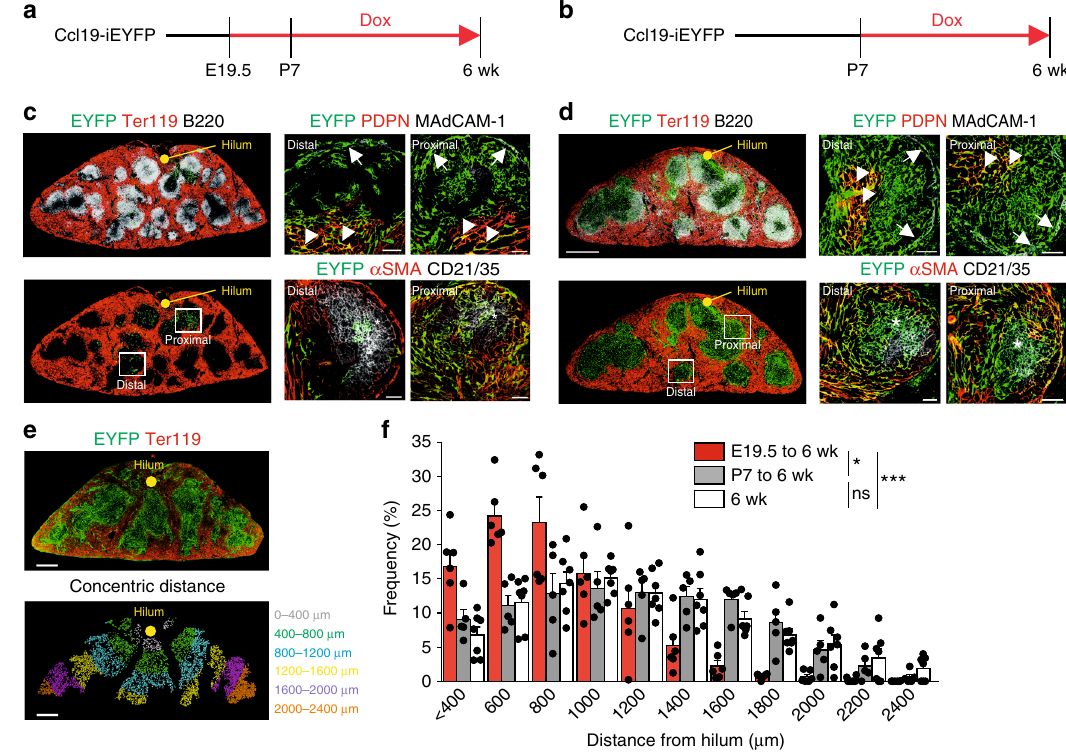
Fig. 4 Staggered commitment of splenic white pulp organizer cells along the developing arterial tree. a , b Ccl19-iEYFP mice were treated with doxycycline from E19.5 ( a , c ) or P7 ( b , d ). Distribution and phenotype of EYFP + cells in the white pulp of 6-week-old mice were determined by confocal microscopy using the indicated antibodies. Boxes show region of higher magni fi cation in right images, arrows indicate EYFP + MAdCAM-1 + MRC c , d , arrowheads indicate EYFP + PDPN + TRC ( c , d ), asterisks indicate EYFP + CD21/35 + FDC ( c , d ) (scale bars = 500/20 μ m). e Determination of EYFP + cell distances